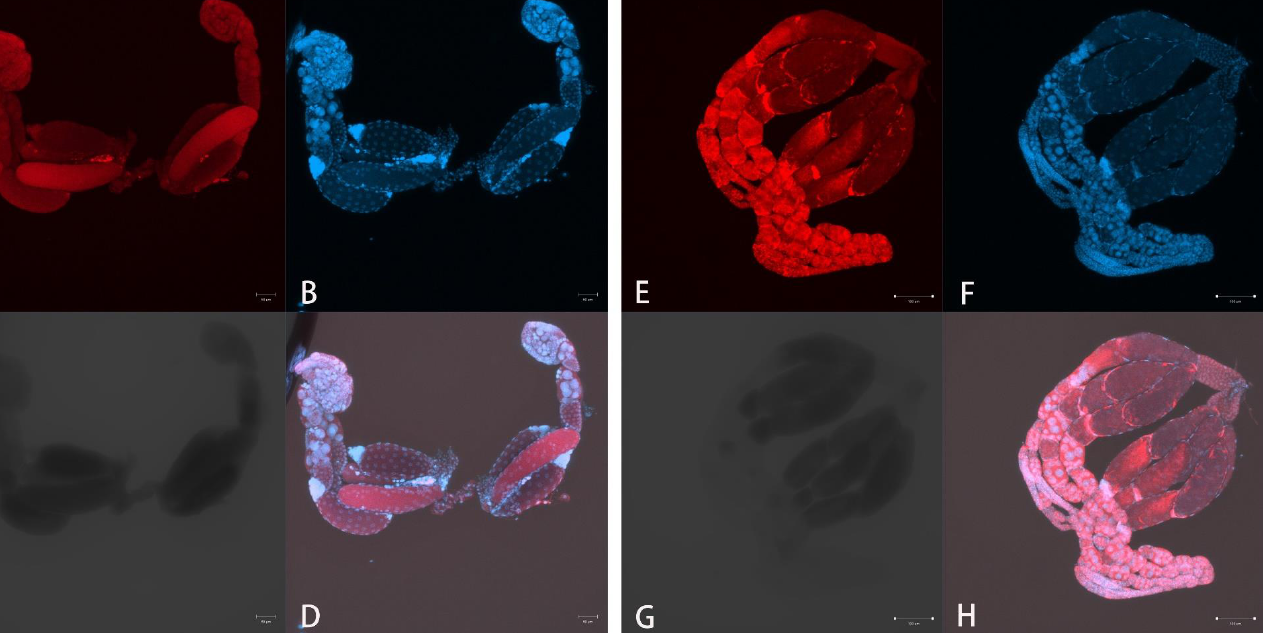
Figure 4. Fluorescence in situ hybridization (FISH) examination of adult ovaries. ( A – D ) Diglyphus wani , ( E – H ) Neochrysocharis formosa . Scale bars represent 50 µm. Ovaries are stained with ( A , E ) the universal bacterial probe EUB338-Cy3 and ( B , F ) DAPI. ( C , G ) Ovaries observed under bright field, ( D ) and ( H ) were merged with different channels. Scale bars in ( E – H ) represent 100 µm.